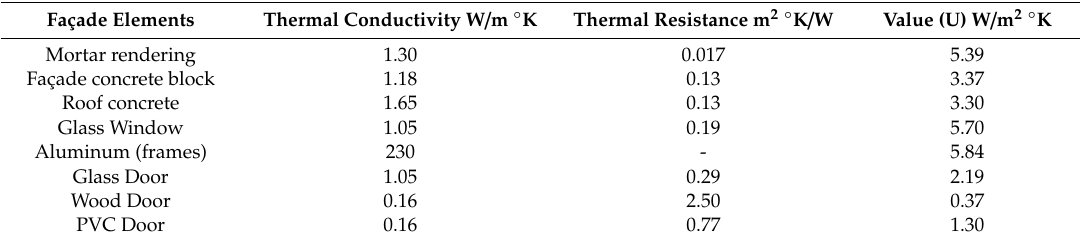
Table 1. Thermal properties of typical building materials in the Dominican Republic.